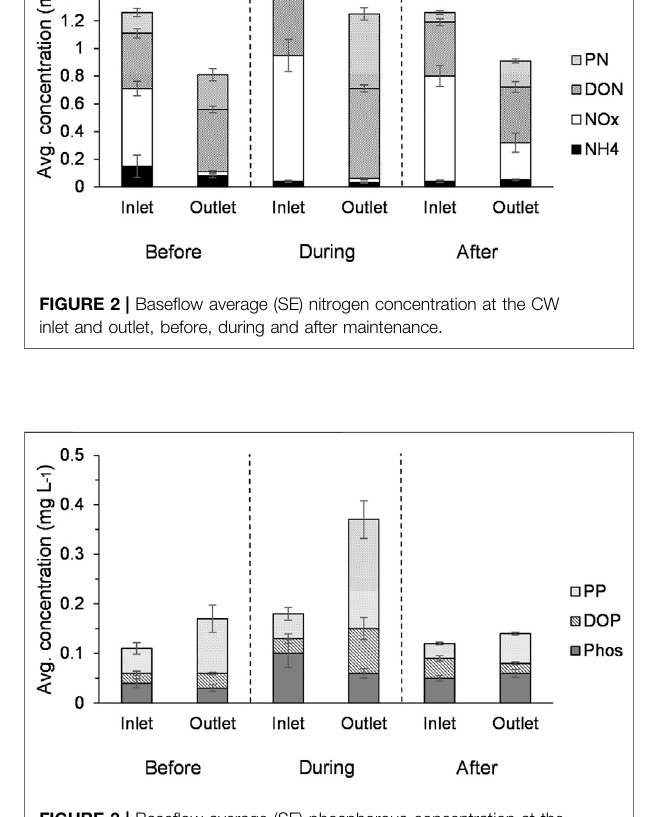
FIGURE 3 | Base fl ow average (SE) phosphorous concentration at the CW inlet and outlet, before, during and after maintenance.